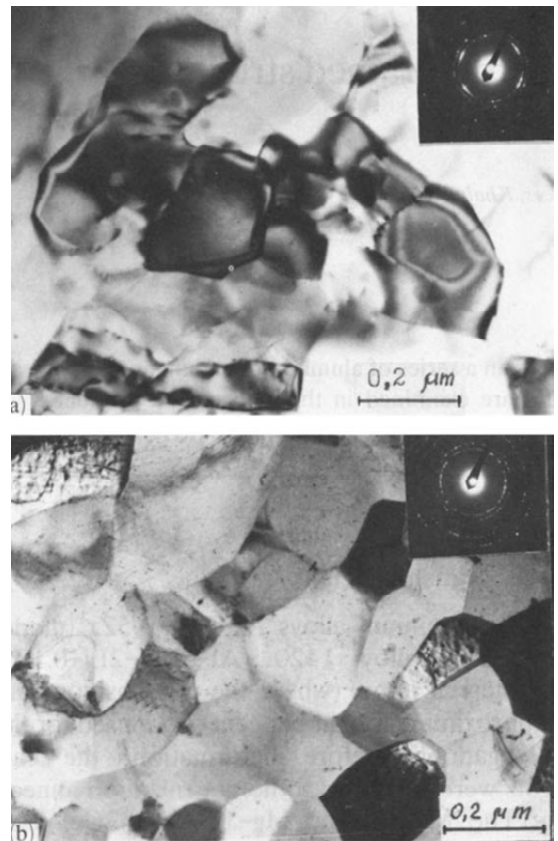
Fig. 1. TEM images and diffraction patterns of Al- Cu-Zr alloy: (a) after high pressure torsion, n = 5; (b) after further annealing at 493K for 1